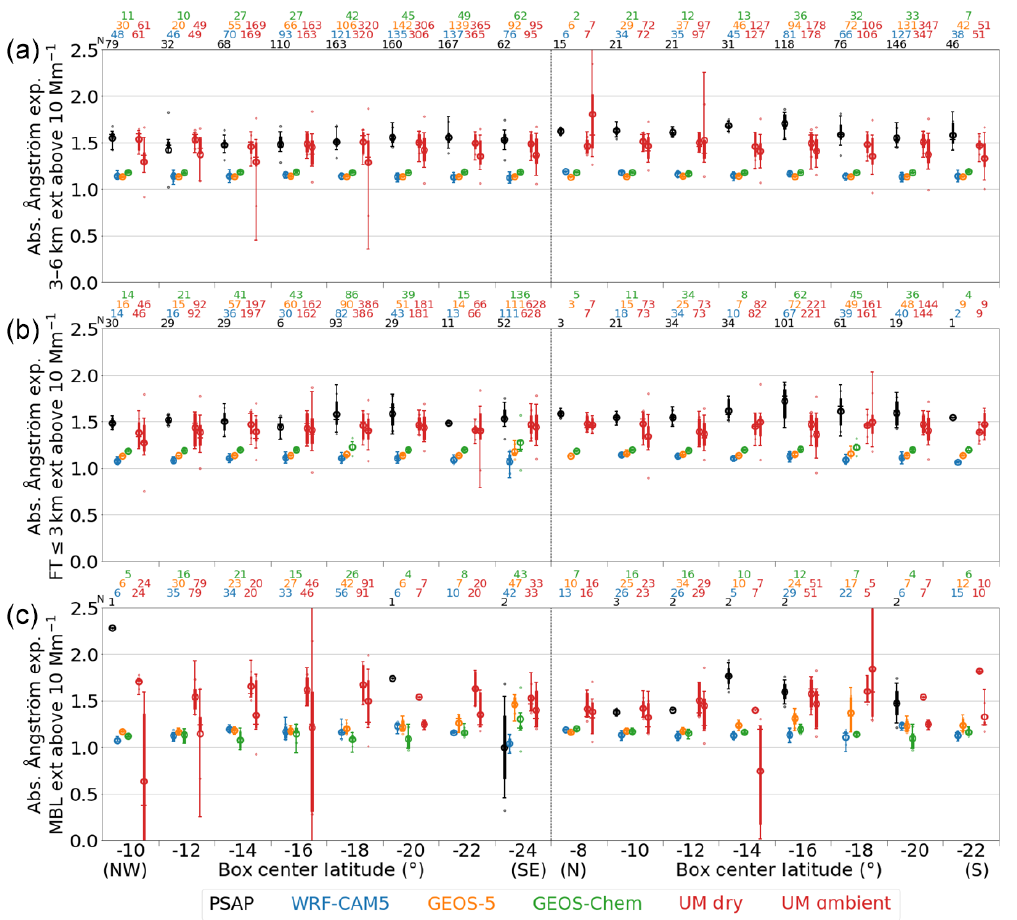
Figure 13. Same as Fig. 6 but for the absorption Ångström